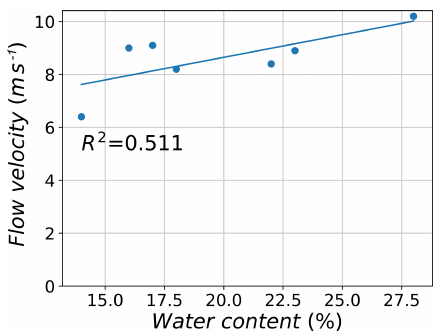
Figure 6. Relation between the water content of the granular ma- terial of selected experimental tests and the observed mean front